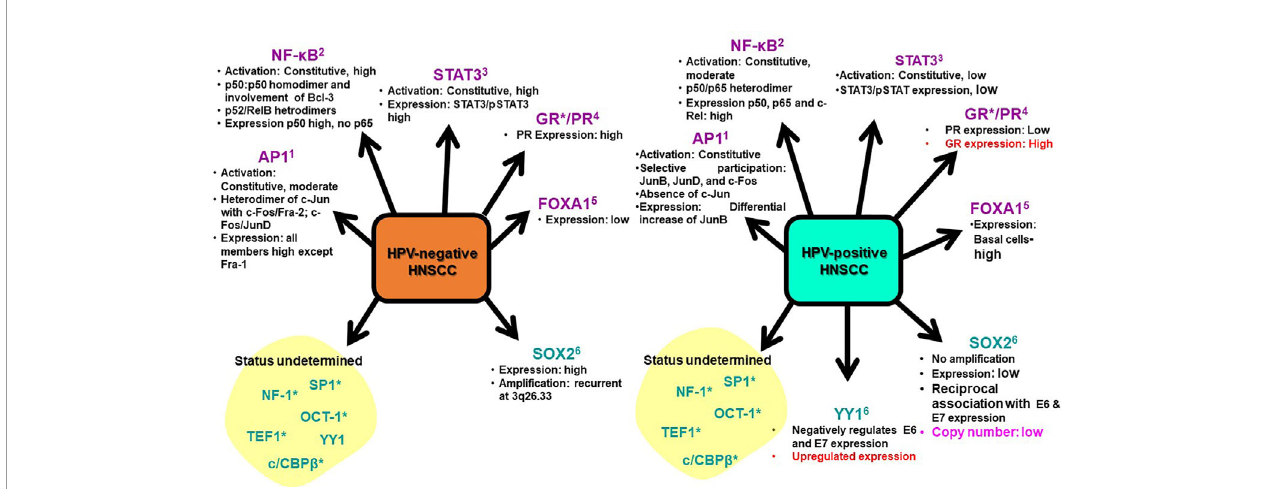
FIGURE 5 | Expression and activity of HPV-related transcription factors in HNSCC. HPV-positive and HPV-negative HNSCC displayed distinguishable transcriptional pro fi les. Transcription factors broadly classi fi ed as inducible (Purple) and constitutively-active (Blue) include: 1. AP1 (Gupta et al., 2015), 2. NF- k B (Fontaine et al., 2000; Bano et al., 2018; Zhang et al., 2018) 3. STAT3 (Gaykalova et al., 2015; Verma et al., 2017), 4. GR/PR (Mohamed et al., 2018; Kost et al., 2019) 5. FOXA1 (Karpathiou et al., 2017; Li et al., 2019) 6. SOX2 (Gut et al., 2018; Dogan et al., 2019) 7. YY1 (Ferris et al., 2005; He et al., 2011). *No speci fi c study in HNSCC. Red text: Data from cervical cancer; Pink text: Data of vulvar